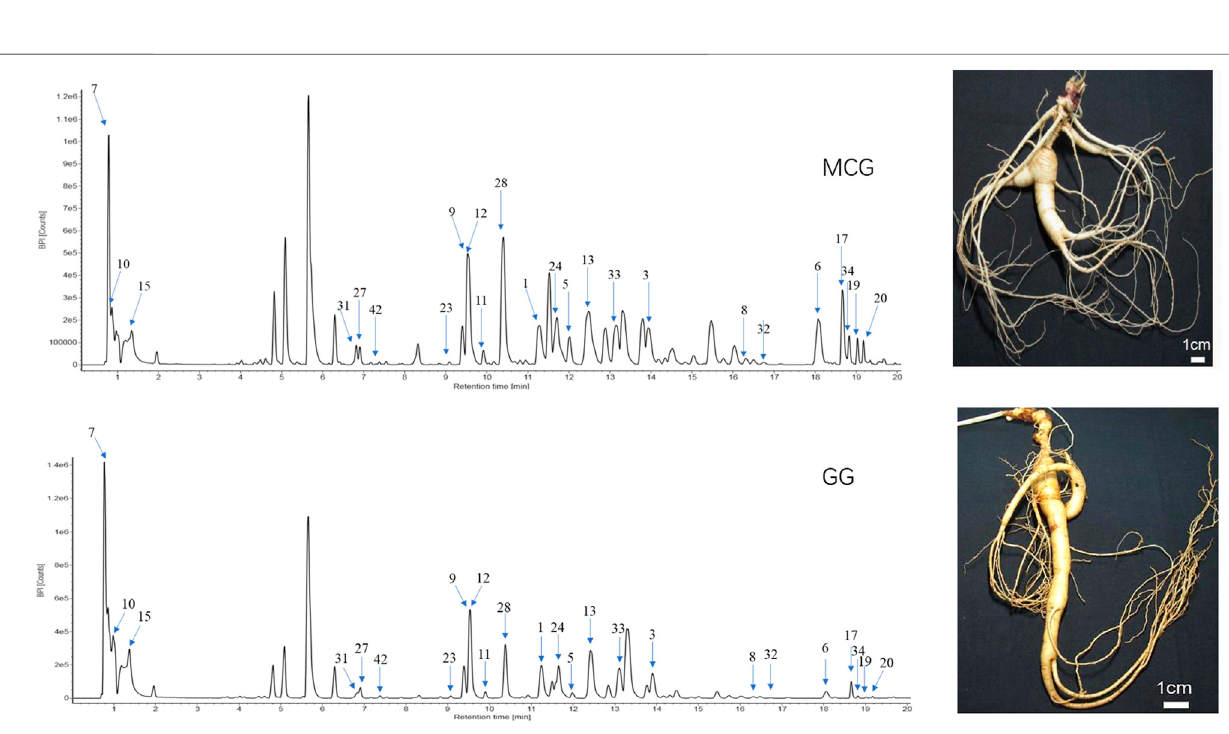
Frontiers in Pharmacology |